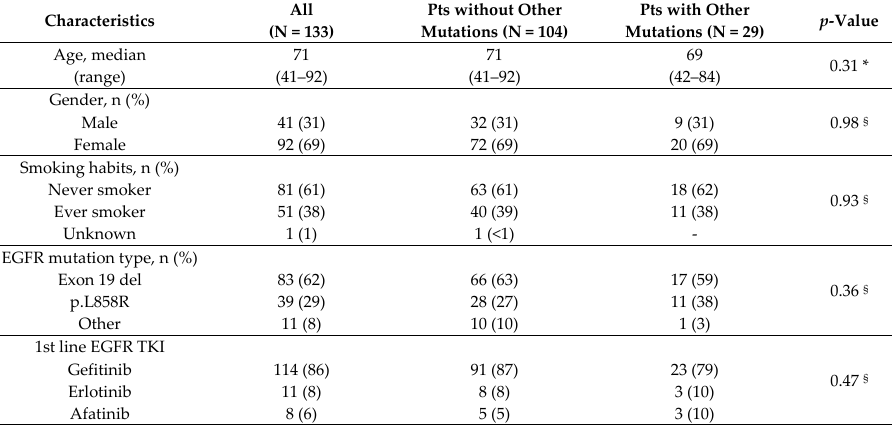
Table 1. Patients’ characteristics.